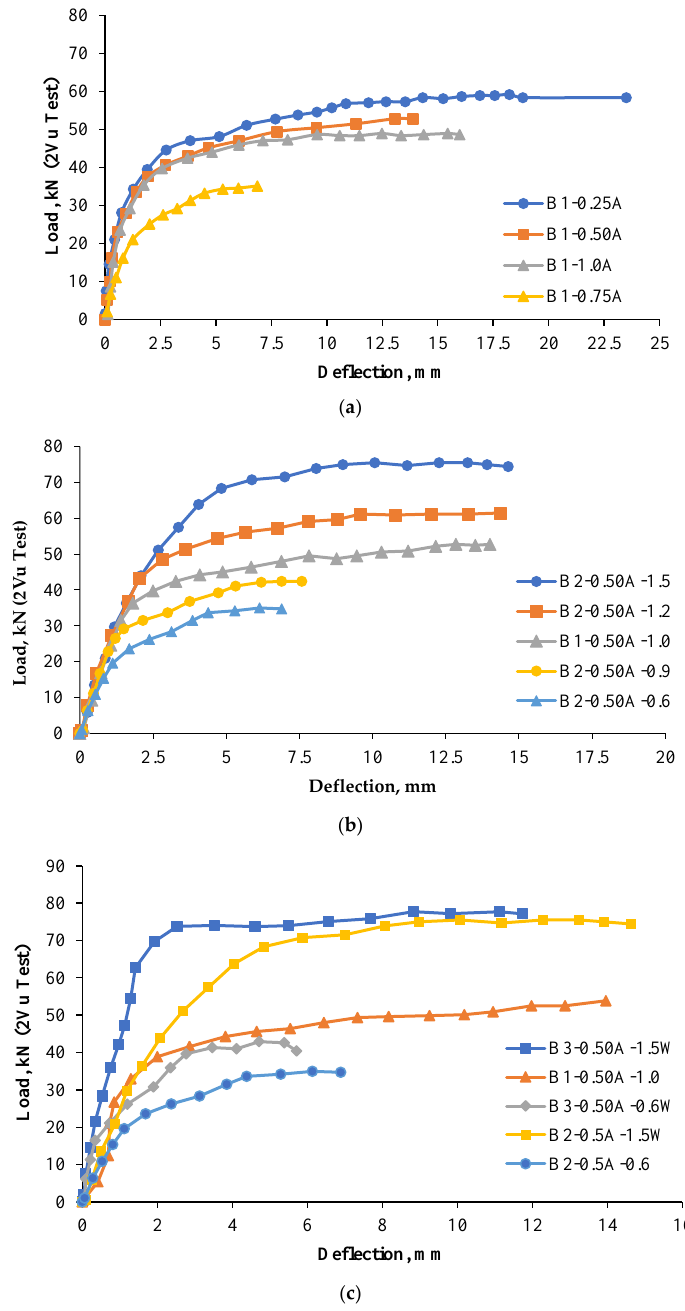
Figure 6. Load vs. deflection response of ( a ) Group I beams, ( b ) Group II beams, and ( c ) Group III